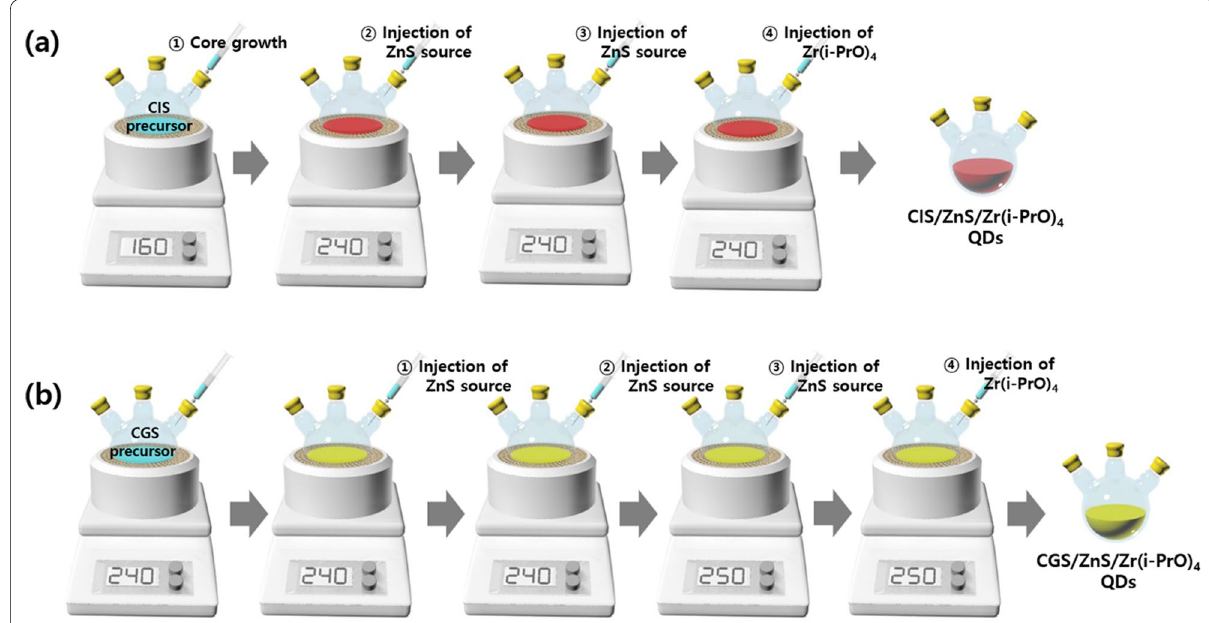
Fig. 1 Schematic diagram of both a red CIS/ZnS and b green CGS/ZnS QDs using multi-step hot-injection method